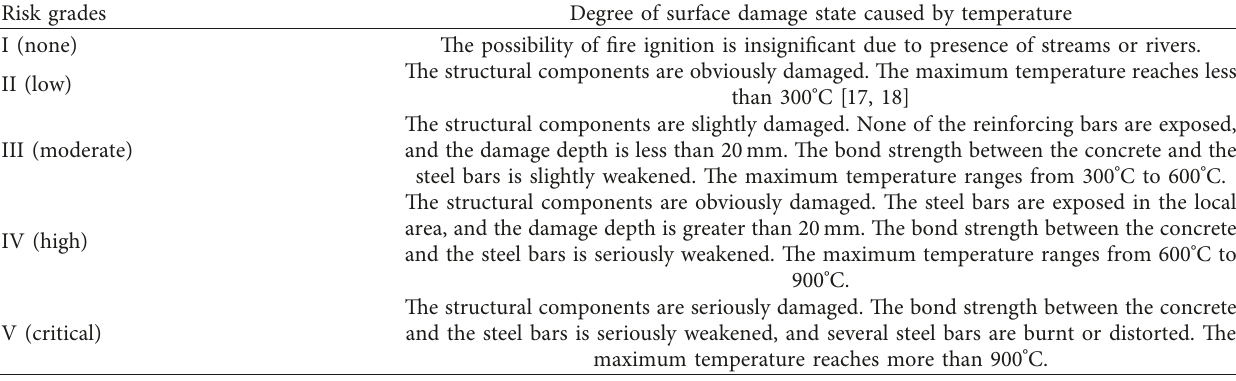
Table 3: Risk grades of concrete bridges [17, 18].